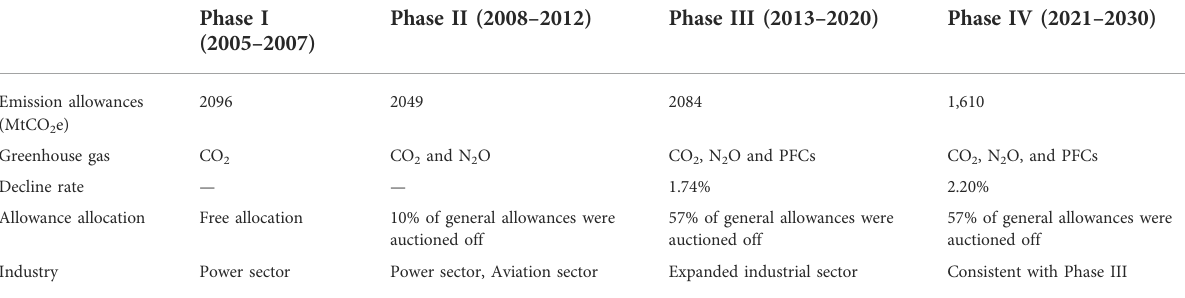
TABLE 1 Characteristics of the different phases of EU-ETS.